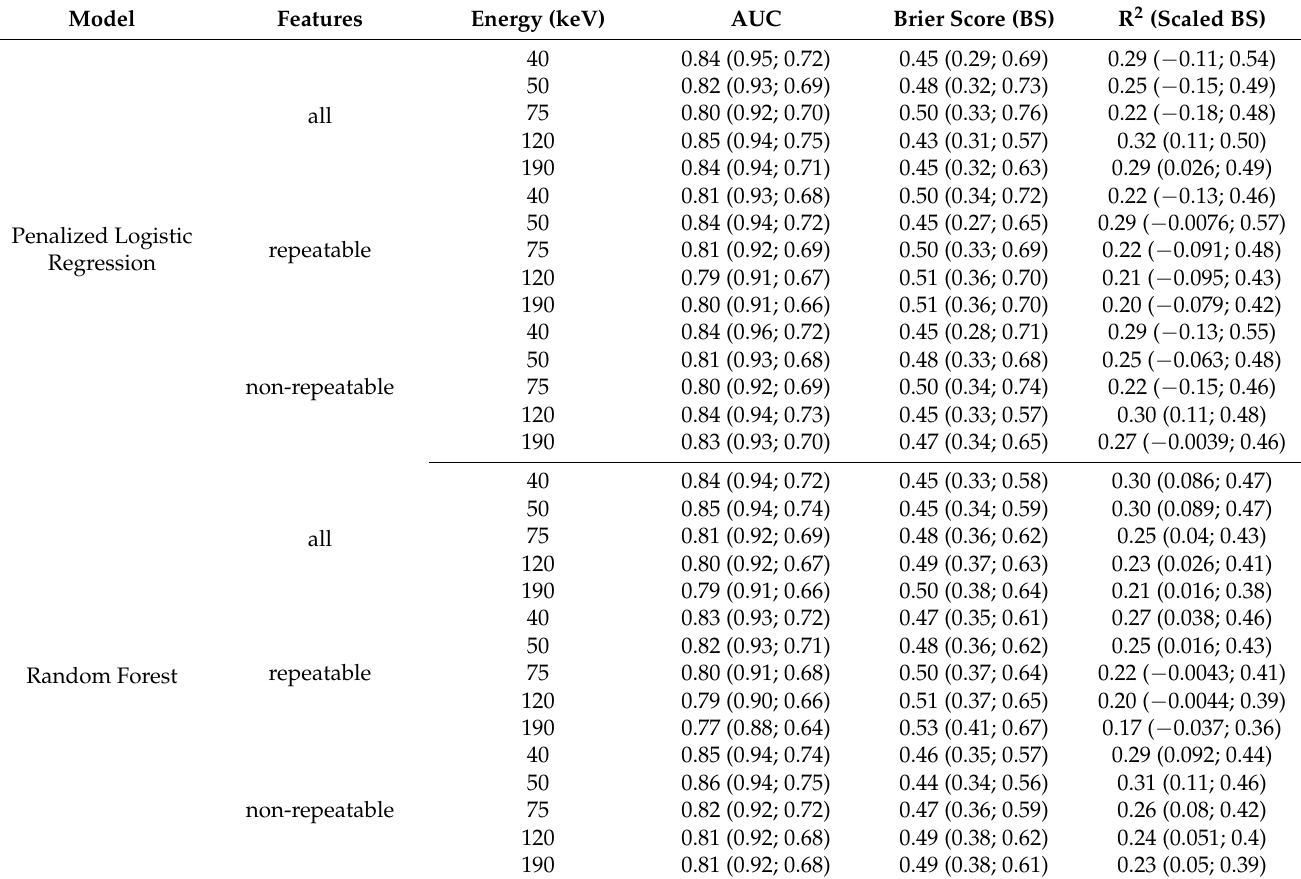
Classification performance (AUC averaged over all classes) and prediction ((scaled) BS) for different VMI energies, feature subsets, and classification models are given in Table 2. AUC ranged between 0.77 and 0.86. Both the lowest prediction error and the best discrimination were achieved using the penalized logistic regression model with all radiomic features of the 120 keV images. Compared to a non-informative model (i.e., one that always predicts the training sample mean frequency) this model reduced the prediction error by 32% (R 2 ). Table 2. In vivo classification performance for different machine learning models, feature selection strategies, and VMI energies. Model Features Energy (keV) AUC Brier Score (BS) R 2 (Scaled BS)